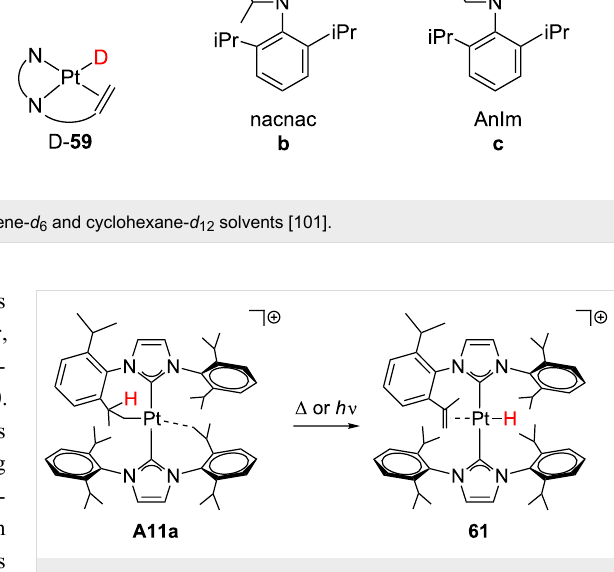
Scheme 26: β -H elimination process of A11a